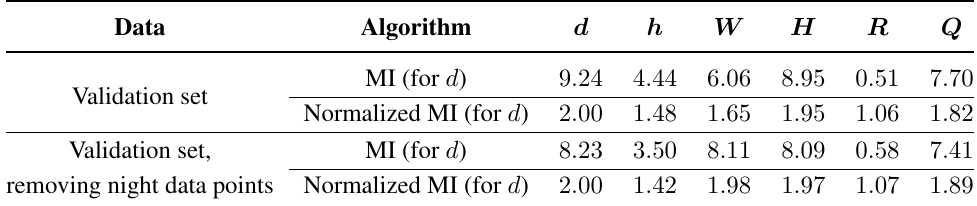
Table 6. Mutual Information (MI) and normalized MI between considered covariates and the indoor temperature, for the validation